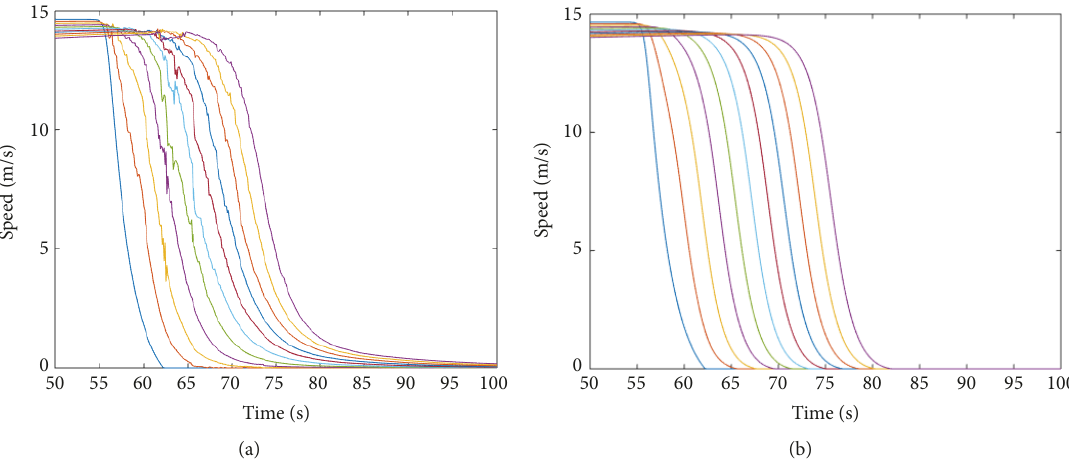
Figure 7: Velocity evolution curves of the braking process of (a) the proposed model and (b) FVD model ( 𝜆 = 0.45 , 𝑝 1 = 0.2 , 𝑝 2 = 0.05 , and 𝑝 = −0.2 3